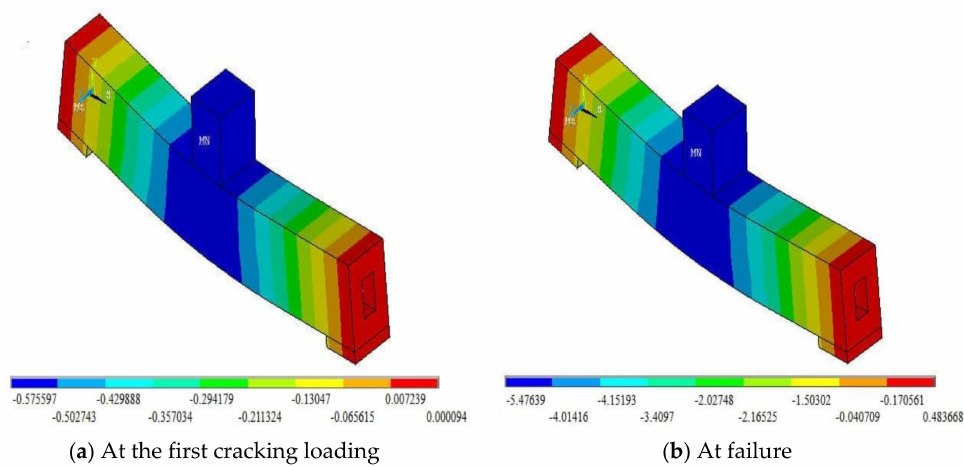
Figure 13. 3D deflection contours of beam model B5 at different loading stages.